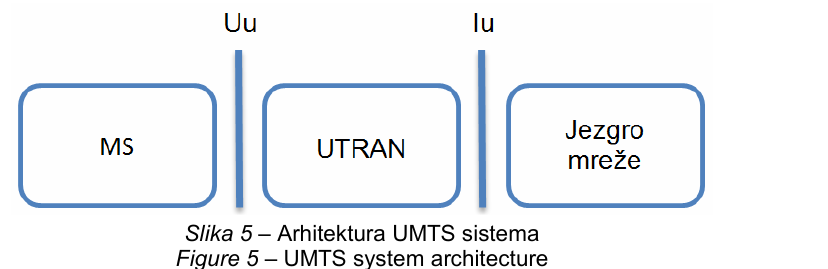
Figure 5 – UMTS system